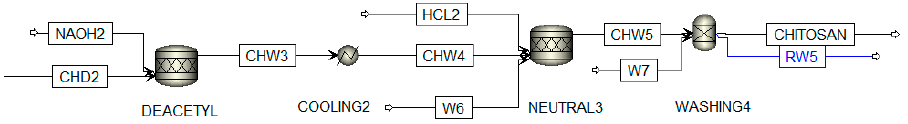
Figure 4. Demineralization and deproteinization reactions. Adapted from Meramo-Hurtado et al. [28].